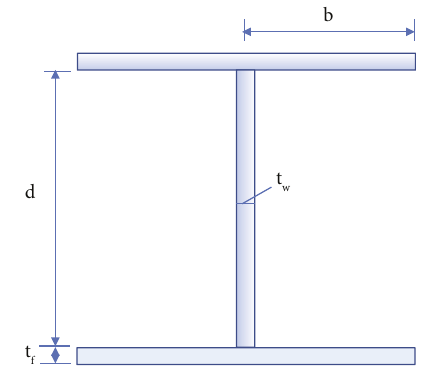
Figure 2: Illustration of the beams’ cross section and considered variables.